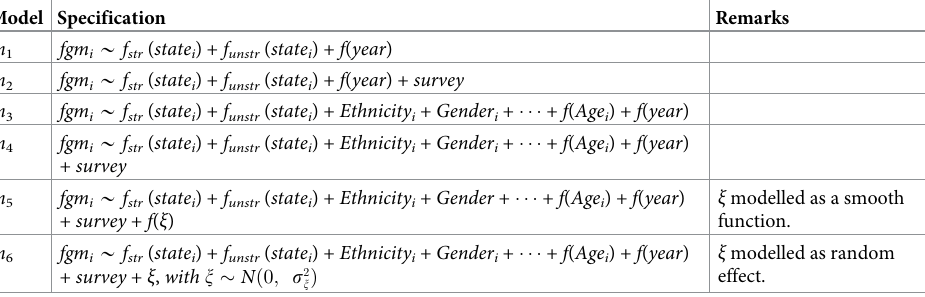
Table 2. Specifications of the model fitted to the